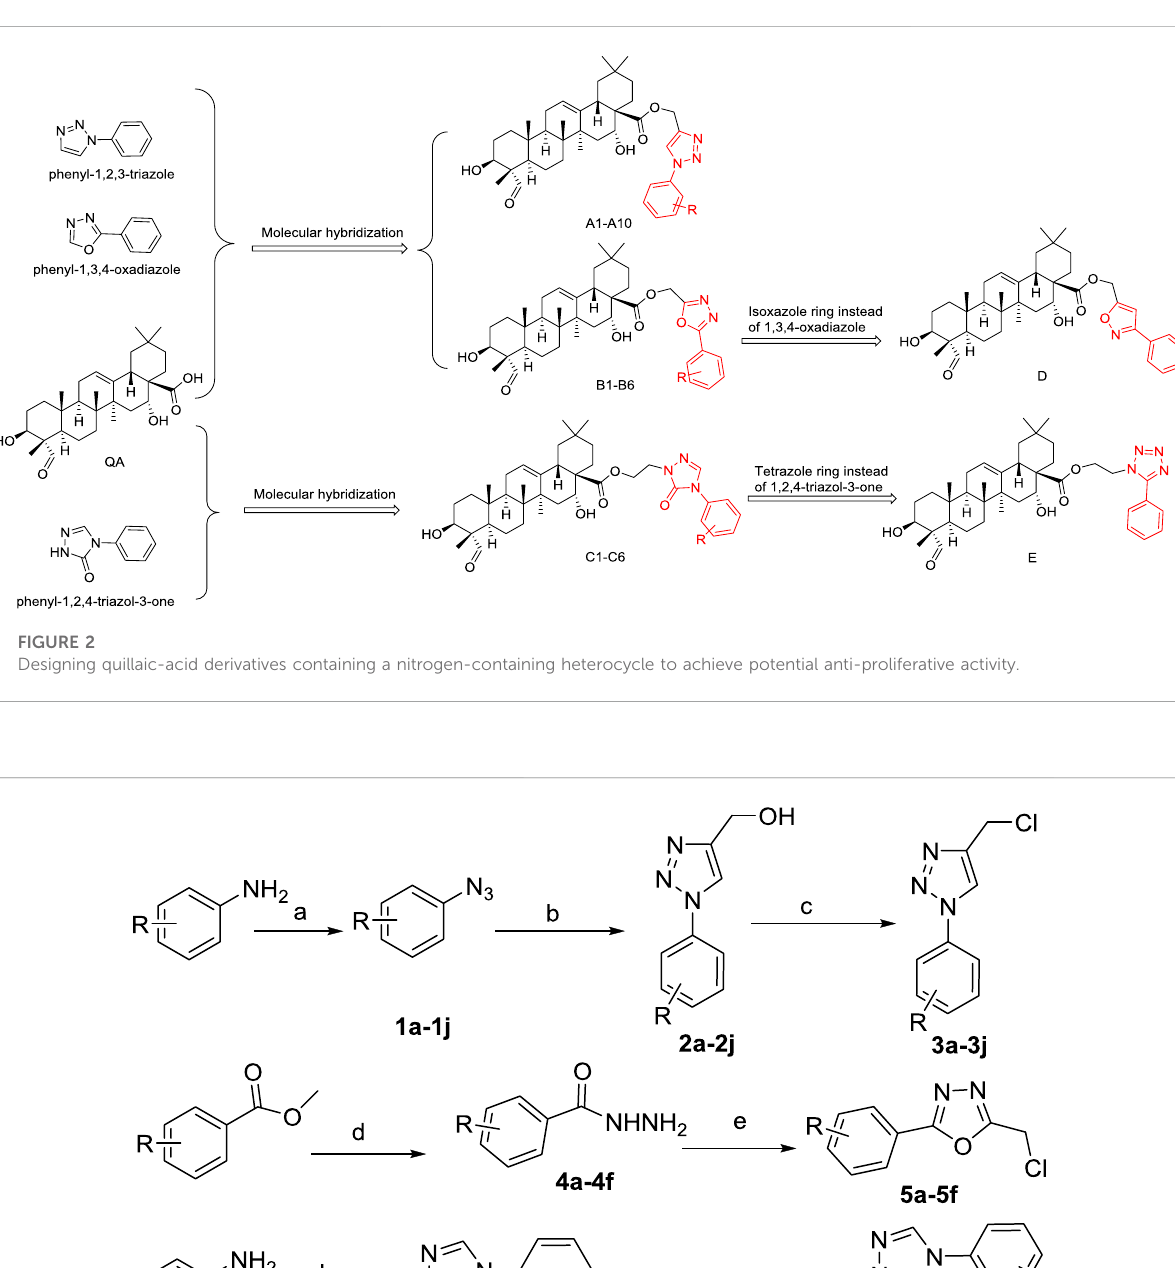
SCHEME 1 Reagentsandconditions: (A) (i)HCl,NaNO 2 ,H 2 O,0 – 5 ° C,30 min;(ii)NaN 3 ,H 2 O,0 – 5 ° C,2 – 4 h; (B) propynol,Naascorbate,CuSO 4 t-BuOH/H 2 O, 25 ° C, overnight; (C) thionyl chloride, CH 2 Cl 2 , r. t., overnight; (D) NH 2 -NH 2 re fl ux, 4 h; (F) (I) methyl hydrazinocarboxylate, triethyl orthoformate, EtOH, re fl ux, 48 h; (ii) NaOCH 3 , EtOH, re fl ux, 48 h; (G)